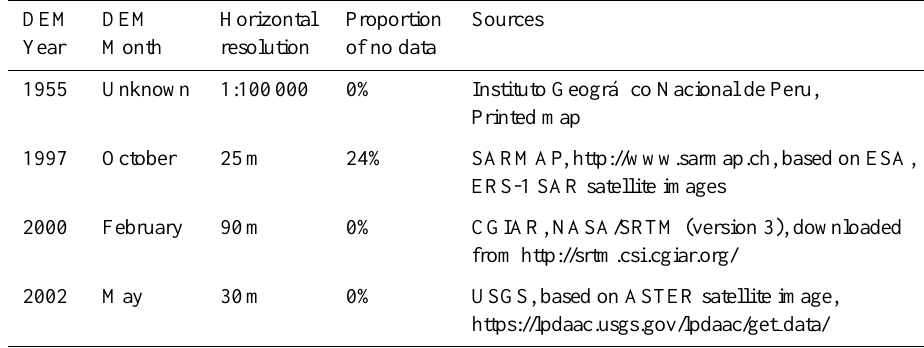
Table 2. Sources and general information for the digital elevation